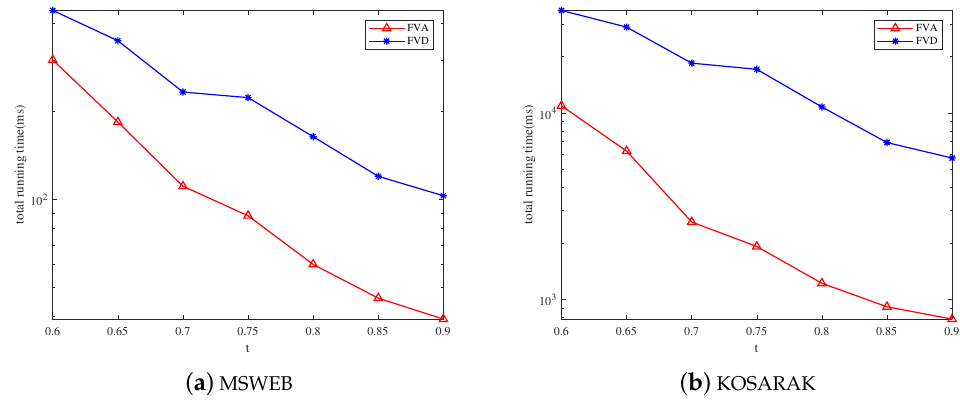
Figure 5. The results for different orderings.